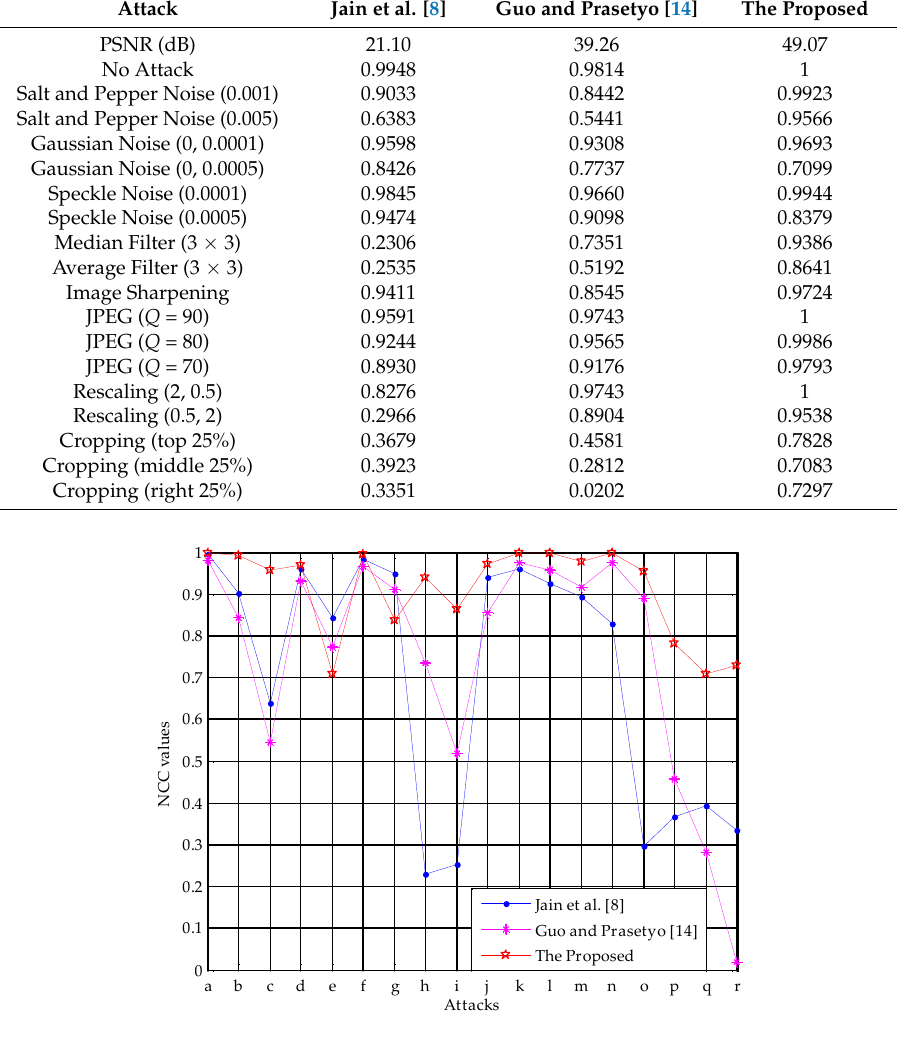
Table 3. NCC values of the extracted watermarks in image Lena under different attacks.